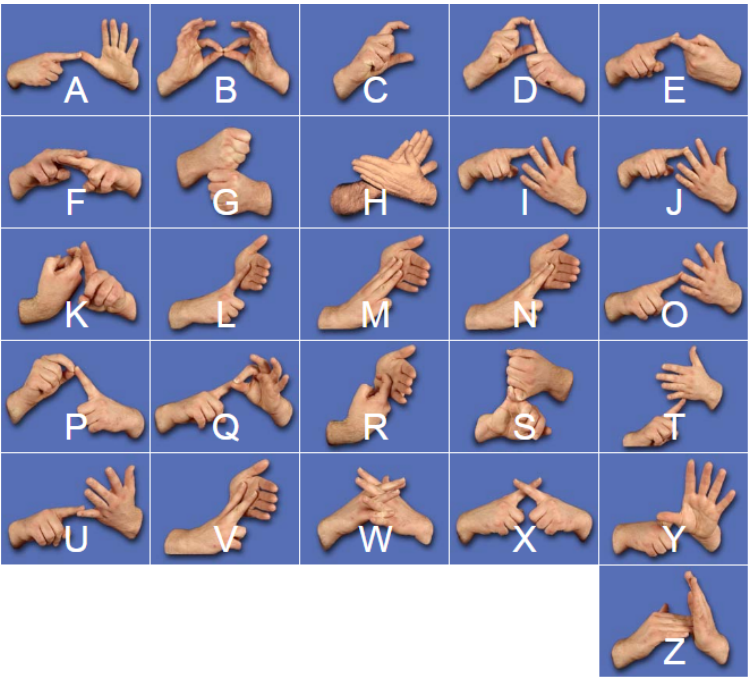
Figure 1: BSL fingerspelling system (from BSL SignBank; http://bslsignbank.ucl.ac.uk/spell/twohanded.html; Fenlon et al.